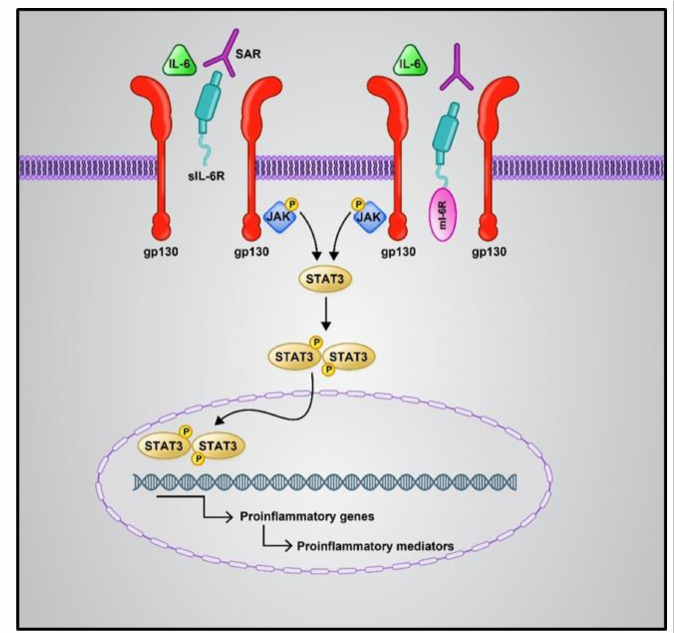
Figure 1. Cis and trans IL6 signaling pathways. The cis pathway is mediated by mIL6R as an anti- inflammatory, while the trans-signaling pathway is mediated by sIL6-R as a pro-inflammatory. Both the IL-6 signaling pathways converge in the activation of the JAK/STAT pathway. Phosphorylation of the receptor associated JAK1 is induced by the binding of numerous cytokines or growth factors to their specific receptors; then, STAT3 phosphorylation occurs via JAK1. Phosphorylated STAT3 is dimerized and transferred to the nucleus, which causes the expression of target genes contributing to angiogenesis, proliferation, immunosuppression, and inflammation; IL6: Interlukine 6, mIL6R: membrane form of IL-6 receptor, sIL6-R: soluble form of IL-6 receptor, JAK: Janus kinase, STAT: signal transducer and activator of